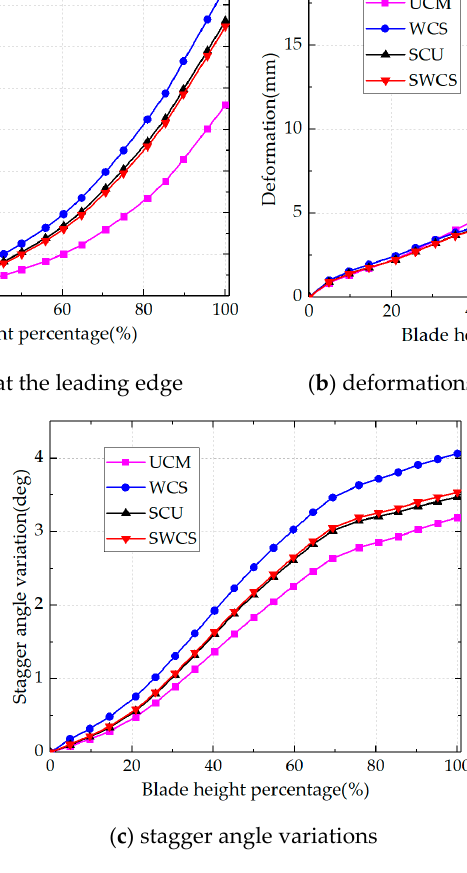
Figure 16. Relative deformations and stagger angle variations along blade height.